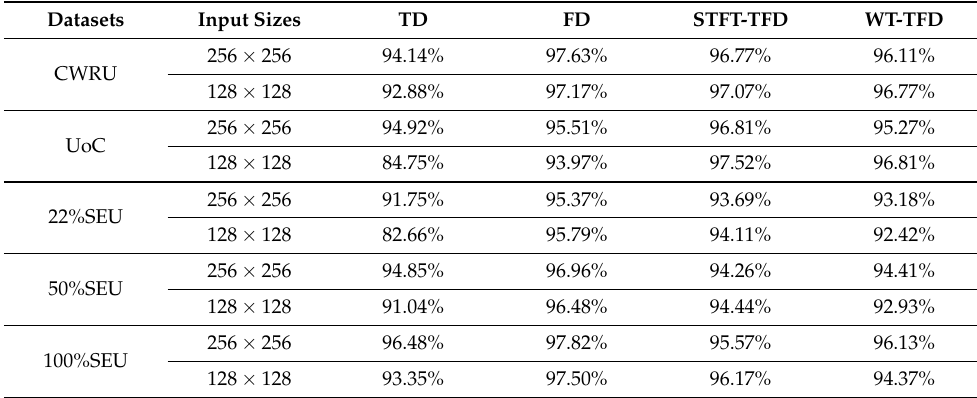
Table 10. Test accuracies of the evaluation with